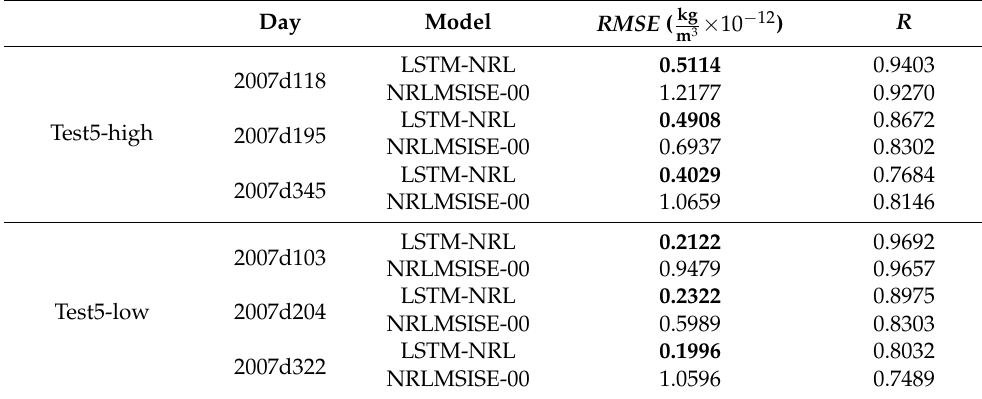
Table 6. The performance of the LSTM-NRL in Test 5. It is noted that the best results, in terms of RMSE and R , are bold in the